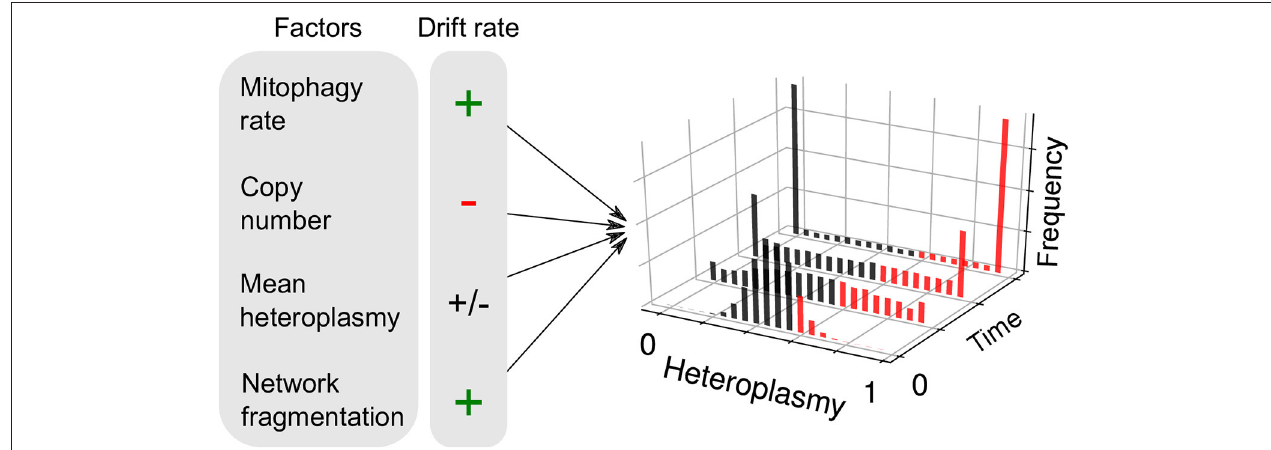
FIGURE 2 | Factors influencing neutral genetic drift of mtDNA. Heteroplasmy ( h , the fraction of a particular variant allele of mtDNA per cell) is not generally constant between cells: it is a random variable and yields a distribution of cellular states. If the consensus and variant alleles experience the same instantaneous birth and death rates per cell, then the heteroplasmy distribution is subject to “neutral drift.” Neutral drift is characterized by the increase in variance of the heteroplasmy distribution with time. It is thought that when cells exceed a particular threshold heteroplasmy, a pathological phenotype may be expressed (red bars). Therefore, the number of pathological cells may increase with heteroplasmy variance. Mathematical modeling has shown that the rate of increase of heteroplasmy variance V ( h ) increases with mitophagy rate, as higher turnover provides more opportunities for replication of either allele and cause a change in h . V ( h ) changes with copy number, since large populations are more robust to fluctuations. For a given spread of heteroplasmies, V ( h ) changes at a maximal rate when mean heteroplasmy is 0.5, and diminishes as one allele dominates over the other. It has recently been shown that mitochondrial network fragmentation can rescale the turnover rate: larger fragmentation results in V ( h ) increasing faster with time—as more mitochondria are susceptible to mitophagy—independently of the absolute fusion-fission rates (see Equation